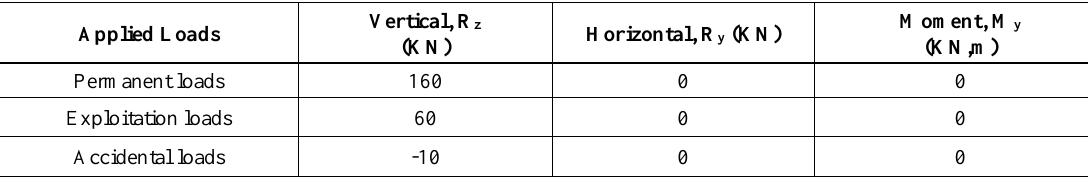
Table 1. Coordinate systems with respect to x, y and z-axis